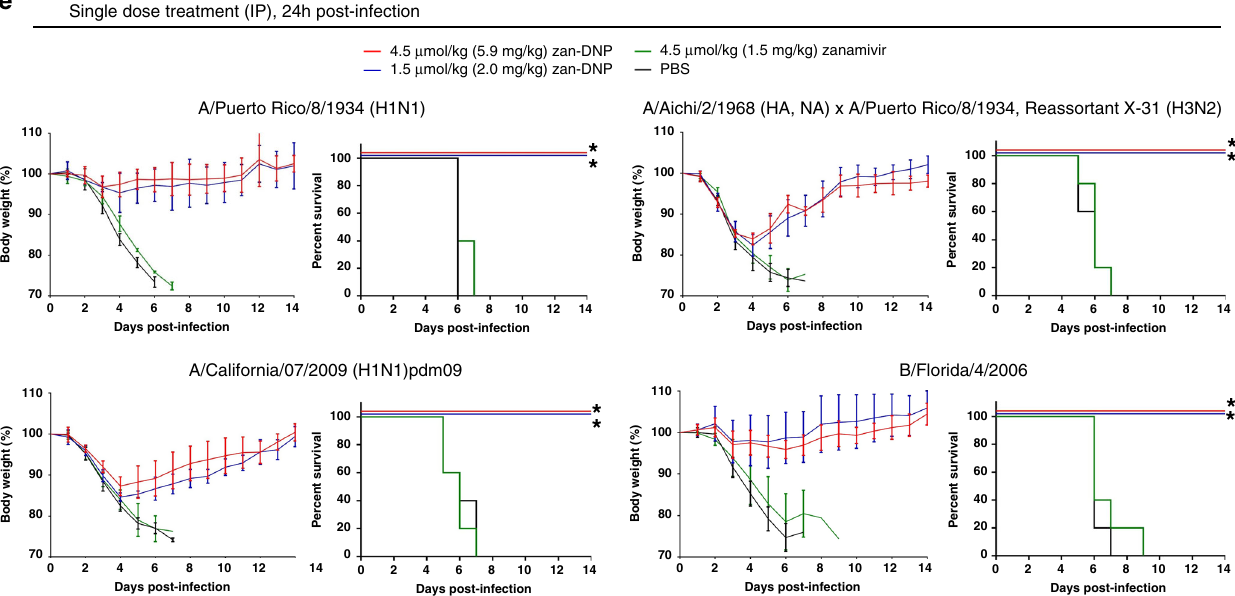
Single dose treatment (IP), 24h post-infection